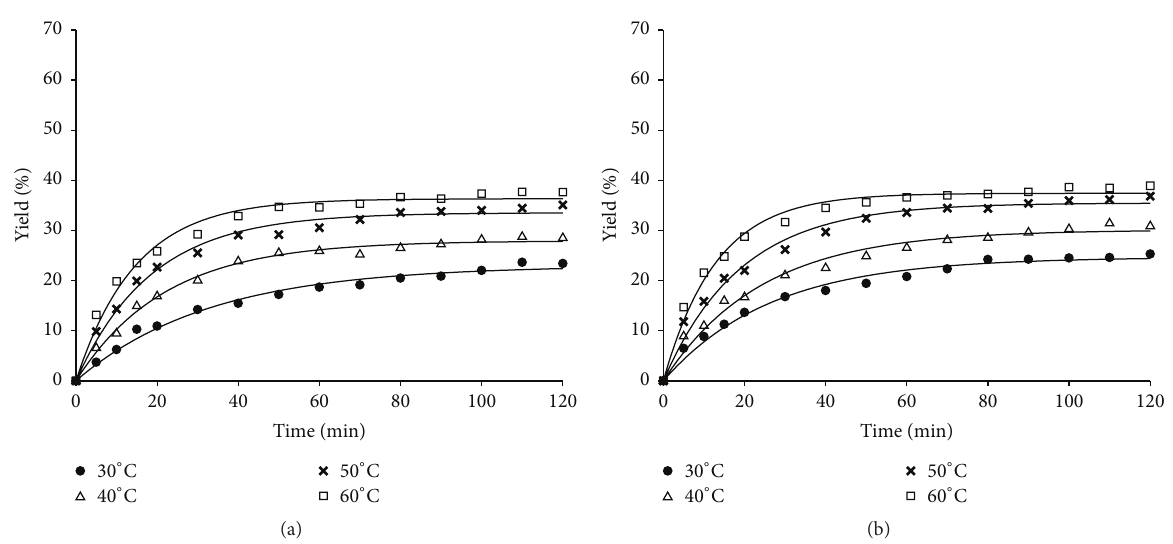
Figure 3: Kinetics of Jatropha oil extraction for an average particle size equal to 2.80 mm and moisture content of 0% (a) and 8.73% (b) at different temperatures.